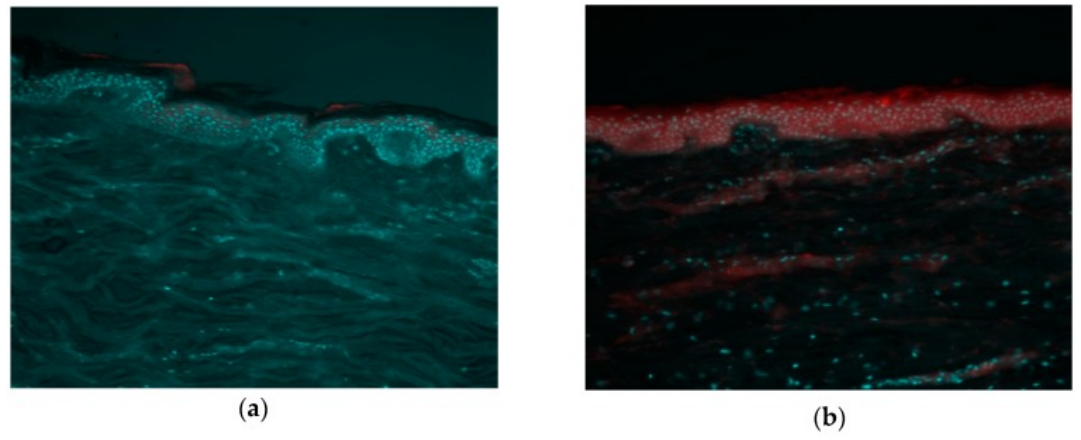
Figure 8. Fluorescence microscopy images of a pig-ear skin cross-section. Red color corresponds to Nile red fluorescence and blue to Hoeschst staining of the cell nucleus. ( a ) Not vehiculized Nile red control (image J, mean epidermis intensity 7846 ± 140 AU); ( b ) Nile red-marked transfersomes (image J, mean epidermis intensity 12,428 ± 254 AU). The images were captured using 10 × magnifications